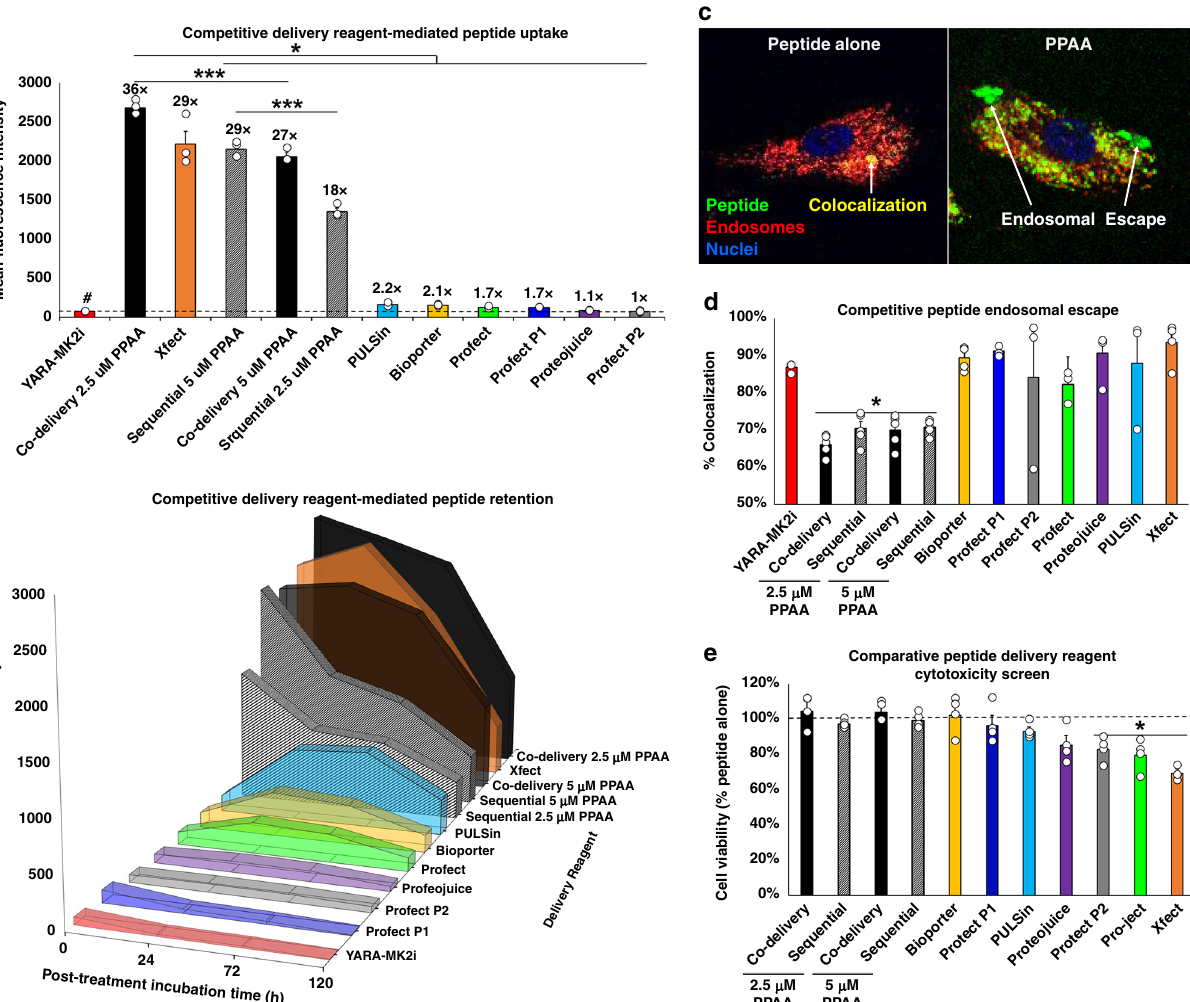
Fig. 2 PPAA outperforms commercially available peptide delivery reagents. Comparison of peptide delivery reagent-mediated a uptake (numbers above the bars denote the fold increase in peptide uptake compared with the peptide alone) and b retention of the YARA-MK2i peptide over time following treatment removal. c Representative colocalization images and d quanti fi cation of peptide colocalization with the endosomal dye LysoTracker Red demonstrating PPAA-mediated endosomal escape and intracellular YARA-MK2i peptide delivery; * p < 0.05 vs. all other treatment groups. e Evaluation of delivery reagent-mediated cytotoxicity compared with delivery of the YARA-MK2i peptide alone (10 µ M peptide); * p < 0.05 vs. treatment with the peptide alone; statistical analyses — one-way ANOVA followed by Tukey ’ s post hoc test. Data are presented as means ± SEM graphically